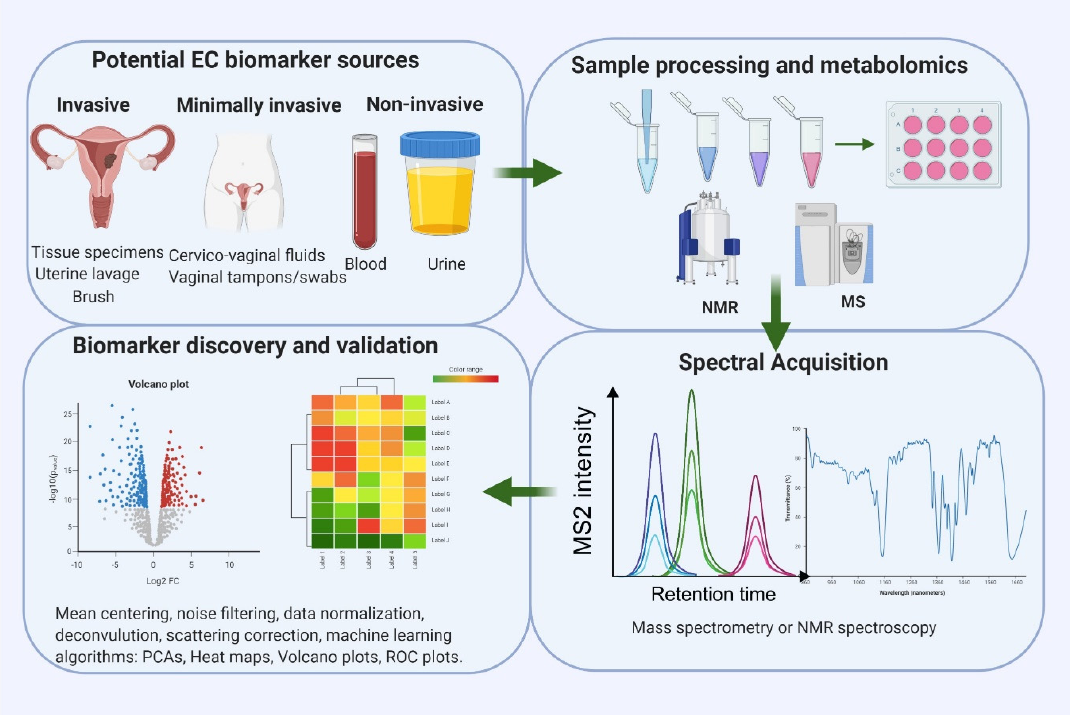
Figure 1. An overview of a typical workflow for endometrial cancer metabolomic biomarker research. Potential sources of endometrial cancer (EC) biomarkers include endometrial tissue specimens, uterine lavage, cervicovaginal specimens, blood and urine. Mass spectrometry (MS) and nuclear magnetic resonance (NMR) analysis are the two main metabolomic platforms for biomarker discovery. Specialised statistical and bioinformatics tools are needed for data analysis, interpretation and integration.